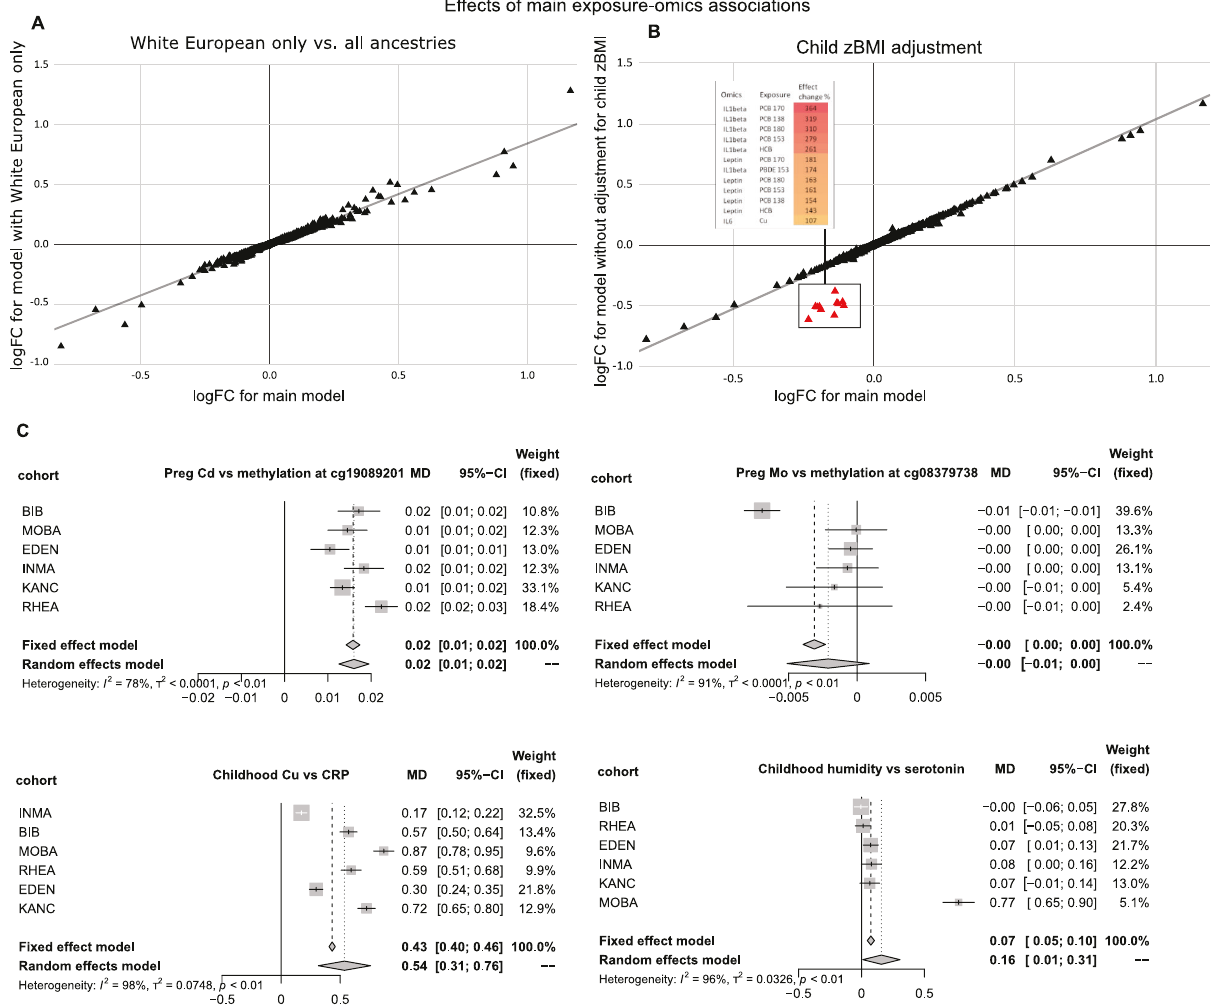
weighted meta-analyses of illustrative exposure – omics associations: maternal Cd levelsandchildDNAmethylationatCpGcg19089201( MYO1G gene)( n =1173),with consistent effects across cohorts; child Cu levels and child CRP levels in plasma ( n =1170),withconsistenteffectsacrosscohorts;maternalMolevelsandchildDNA methylation at CpG cg08379738 ( DENND1C gene) ( n =1173), driven by one of the cohorts (BiB); humidity in childhood (1 month before sampling) and child serum serotonin levels ( n =1198), driven by one of the cohorts (MoBA). Each cohort is represented by a point estimate, bounded by the 95% con fi dence interval (CI) for the effect and the cohort weight as a grey square. The 95% CI from the fi xed and randomeffectsmeta-analysisareshownasdiamonds.Theeffectsizeisreportedas a log2 fold change (log2FC) of the omics, or difference in methylation levels, for interquartile range (IQR) of continuous exposure